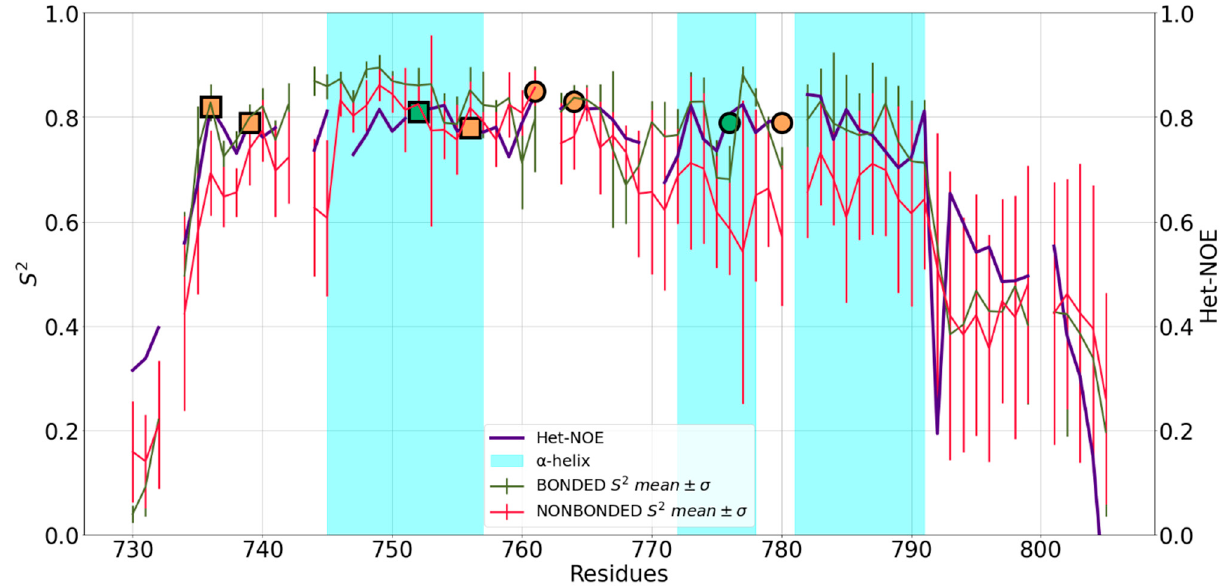
Figure 5. Mean S 2 of 2L7X and standard deviation (SD) for bonded (red) and nonbonded (green) simulations superimposed to het-NOE data (purple). Values on y-axis were truncated at 0 because S 2 had no negative values. Orange markers represent the position in the sequence of zinc(II)-binding Cys residues, whereas the green markers represent zinc(II)-binding His residues. Residues belonging to the same site are represented with the same marker shape (squares: ZF1; circles: ZF2).